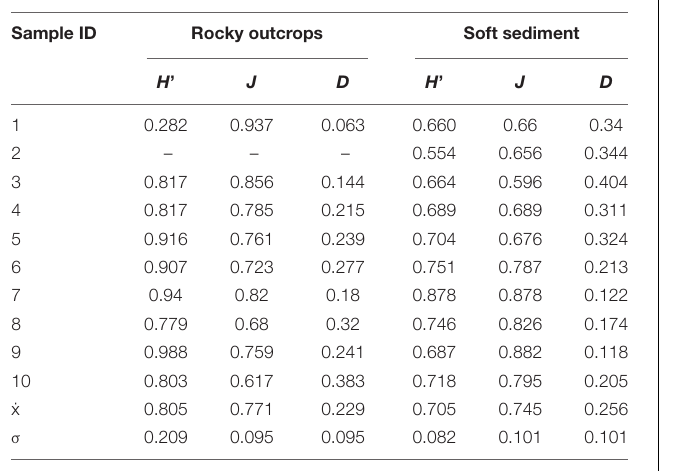
TABLE 7 | Composition of sponge morphotypes found at the NW limit of Guaymas Basin and the Sonoran Margin (849–990 m). Substrate type